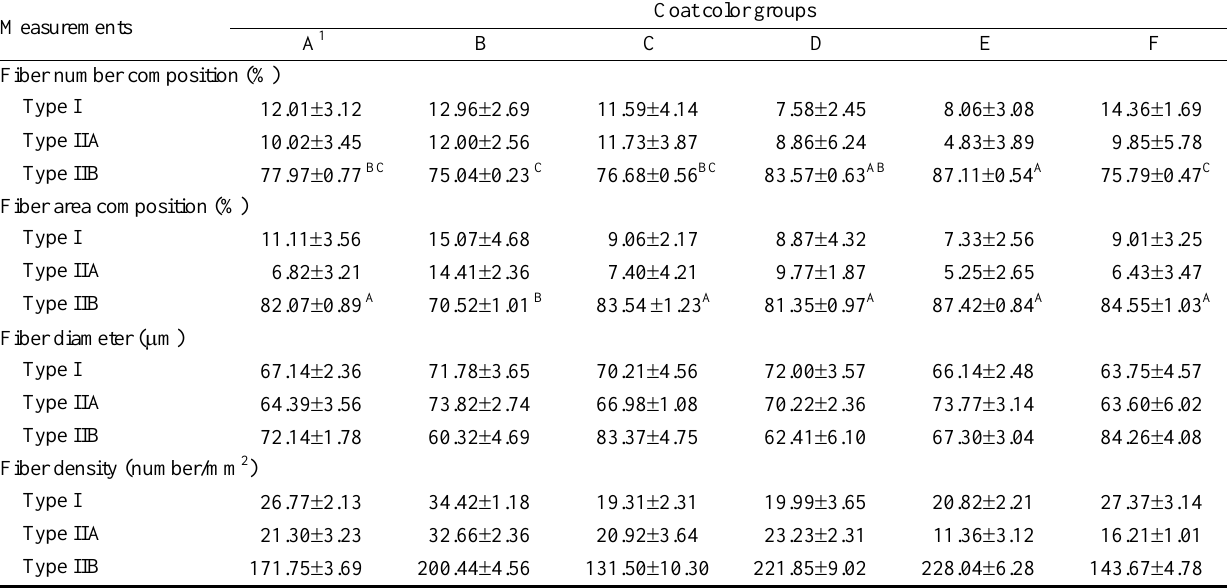
Table 4. Histochemical characteristics of crossbred pigs (KNP  Landrace) F 2 Measurements